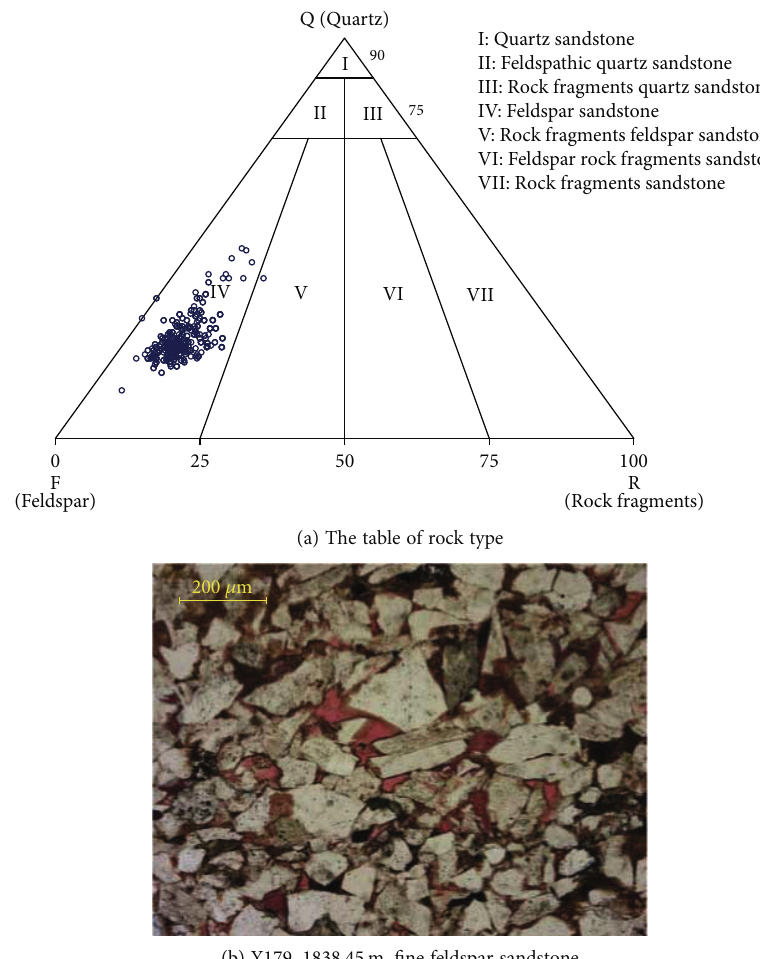
Figure 1: Rock type of Chang 6